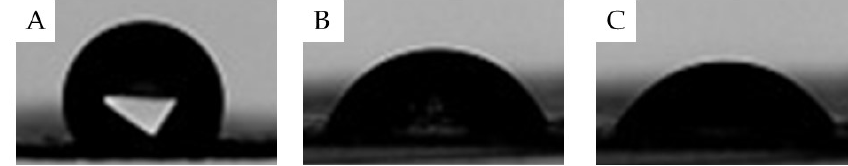
Figure 4. Contact angle images of the samples: ( A ) PU, ( B ) PU-NL, and ( C ) PU-NL/EEP.